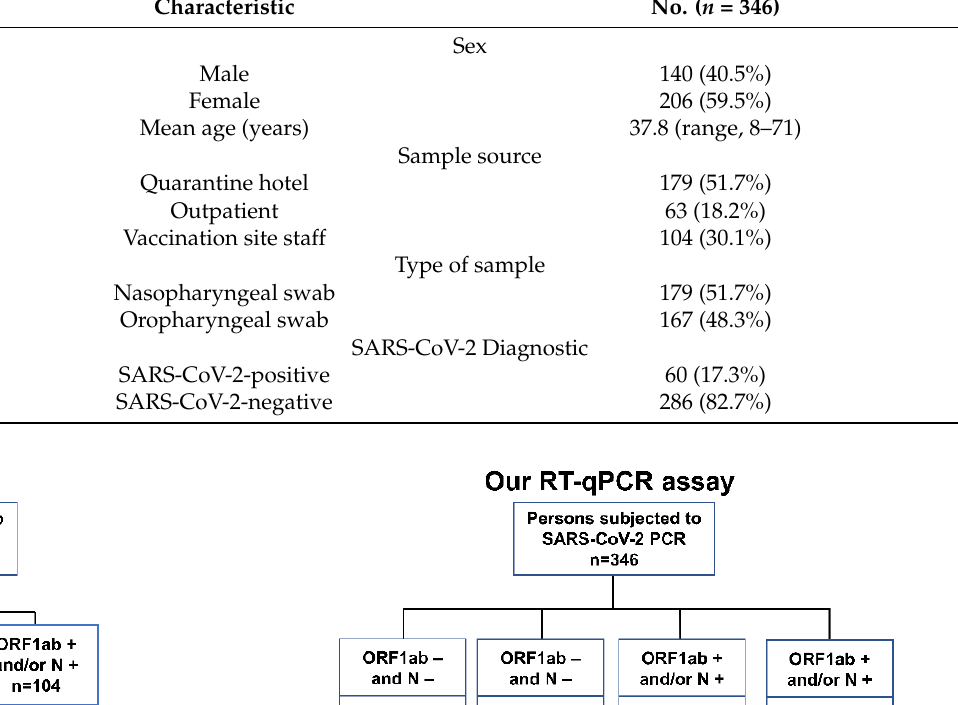
Table 2. Clinical data of 346 clinical samples.